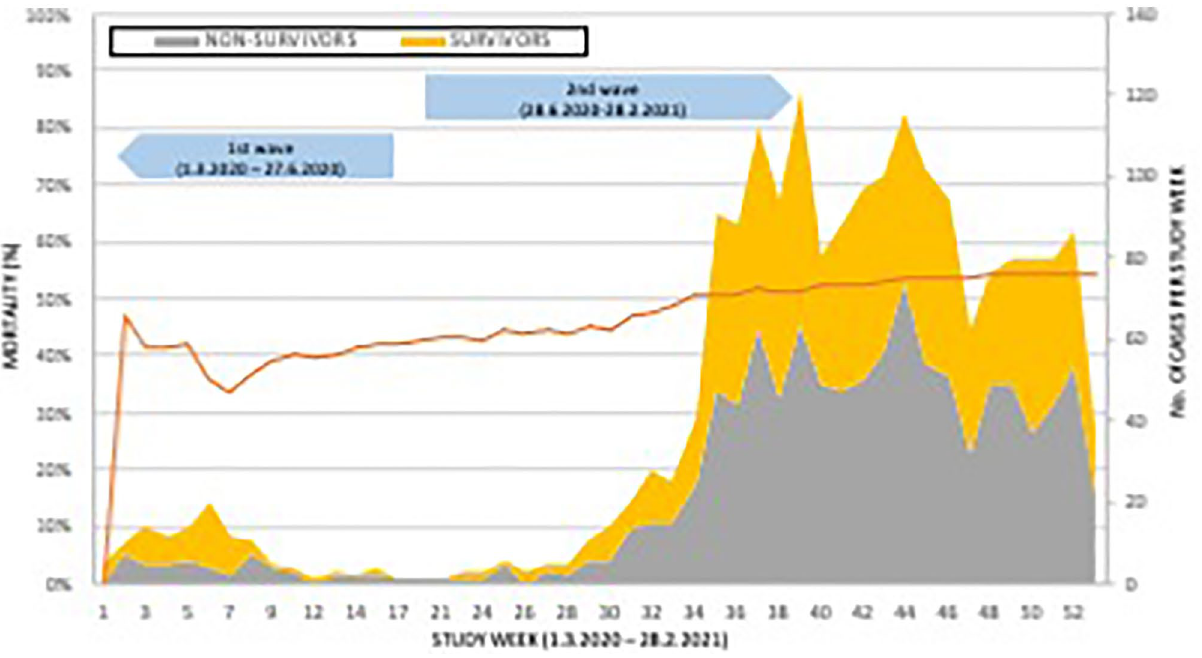
Figure 2. Distribution of survivors and non-survivors, and mortality during the study period. Absolute numbers of surviving (yellow) and non-surviving (grey) patients (right sided Y-axis) based on the inclusion study week (X-axis) are shown. Orange line represents mortality calculated per study week (left sided Y-axis). Arrows depict the limits of 1st and 2nd wave of COVID-19 pandemic.